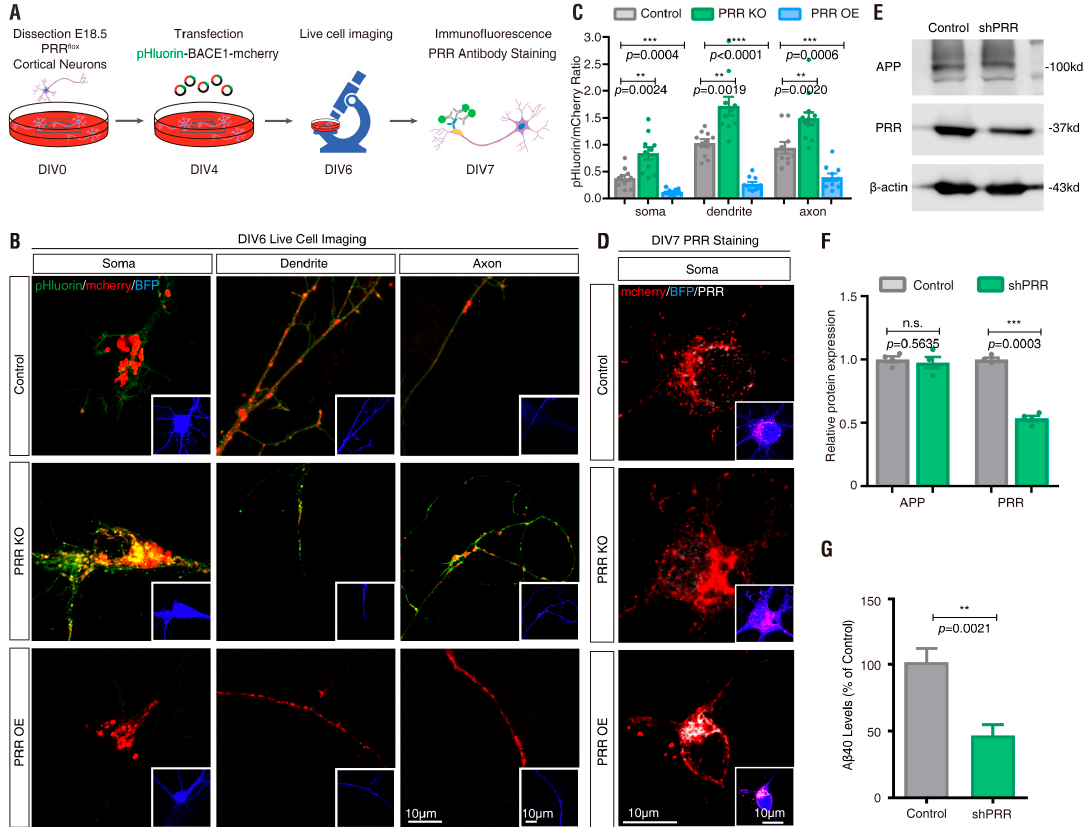
Figure 8. Regulation of pHluorin ‐ BACE1 ‐ mCherry and BACE1 activity by (pro)renin receptor (PRR) in vitro ( A ) Schematics of live cell imaging experimental procedures. Cortical neurons were dissected from E18.5 PRR f/f mice and plated on 35 mm glass ‐ bottom culture dishes at DIV0. Neurons were co ‐ transfected with pHluorin ‐ BACE1 ‐ mCherry and BFP without Cre (control) or with Cre (PRR KO) or with PRR (PRR OE) at DIV4 and underwent live cell imaging at DIV6. Immunostaining of PRR was performed at DIV7. ( B ) Confocal live cell imaging of transfected neurons at DIV6 was carried out and representative images are shown. Scale bar, 10 µm. ( C ) Quantification analysis of the pHluorin/mCherry ratio from B. Data was shown as mean ± SEM ( n > 15 neurons from three independent experiments). Significance was calculated with Student’s t ‐ test; **** p < 0.0001, *** p < 0.001, ** p < 0.01. ( D ) Immunostaining of PRR in transfected neurons at DIV7 was carried out and representative images are shown. Scale bar, 10 µm. ( E ) Western blot analysis of MC3T3 cells infected with control lentivirus or shRNA ‐ PRR lentivirus. ( F ) Quantification analysis of relative protein expression from E. Data was shown as mean ± SEM ( n = 4 from three independent experiments). Significance was calculated with Student’s t ‐ test; n.s. p > 0.05, *** p < 0.001. ( G ) A β 40 levels of control